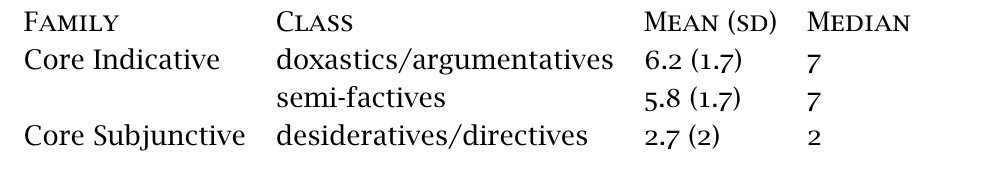
Mean/Median acceptability ratings for the core indicatives and